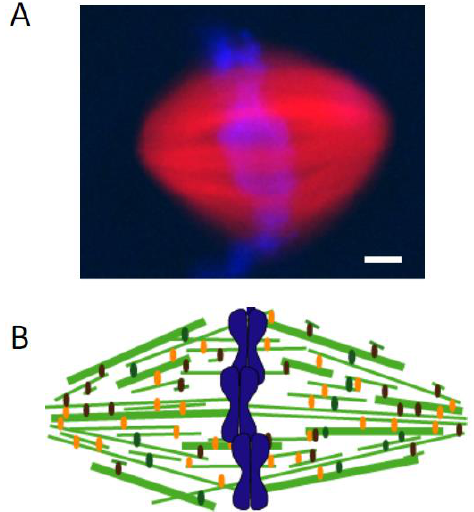
Figure 2. Metaphase spindle assembled in Xenopus egg extracts. ( A ) Overlay shows tubulin (red) and DNA (blue) in a metaphase spindle assembled around demembraned sperm DNA. Rhodamine-labeled tubulin was added to visualize microtubules, and Hoescht was used to stain DNA. Scale bar, 5 µ m; ( B ) Schematic for the spindle assembled in Xenopus egg extracts. Tubulin: green, thicker lines indicate filament bundles; DNA: blue).